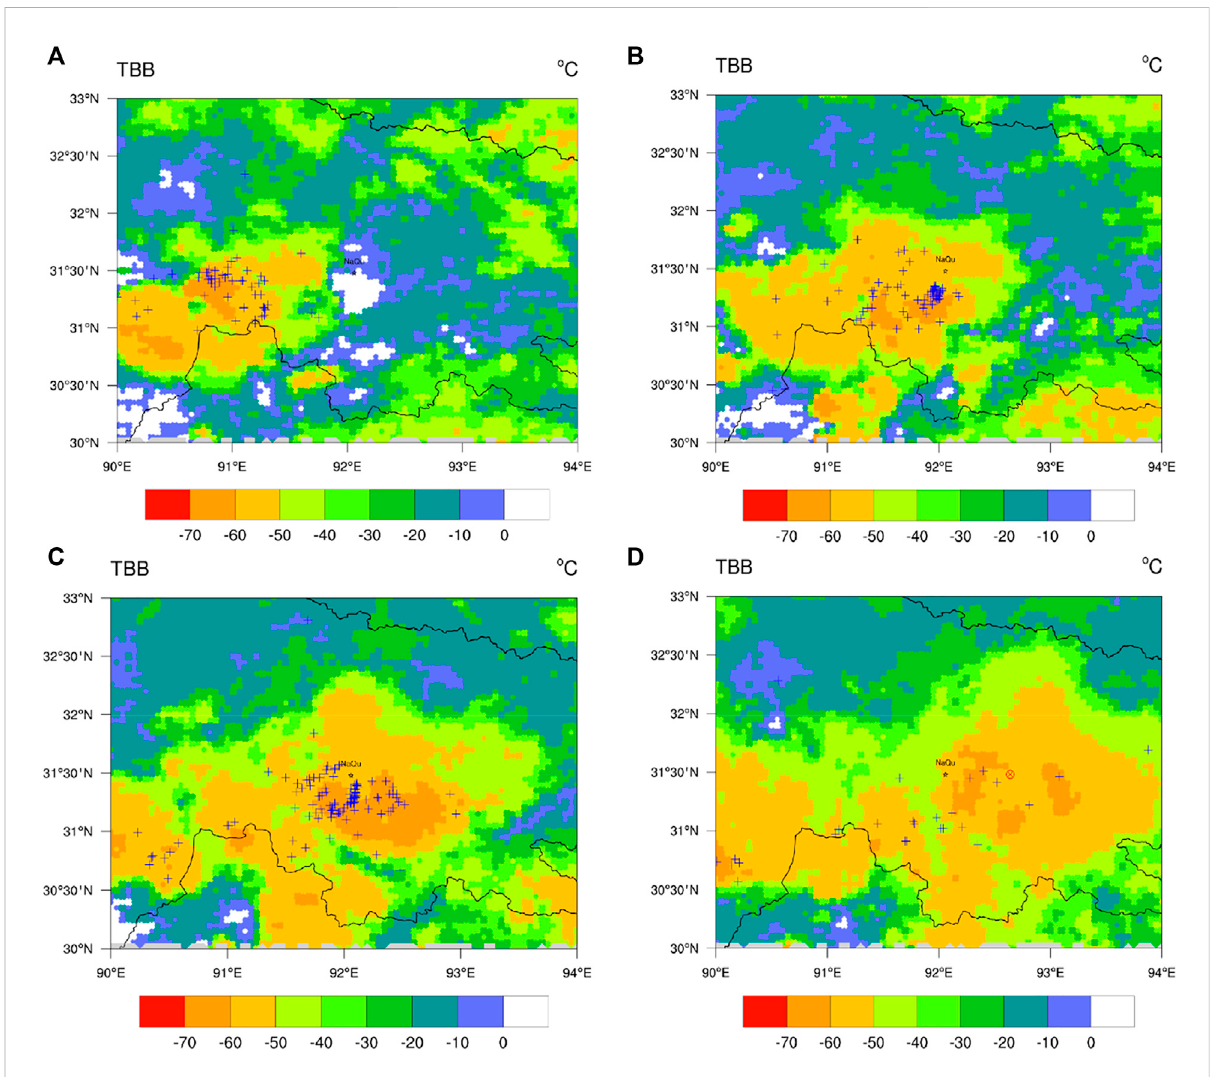
FIGURE 9 TBBsuperimposedonCGlightningat (A) 0,730, (B) 0,830, (C) 0,930,and (D) 1030UTConJuly14(+indicatesnegativeCGlightning, ⊕ indicates positive CG